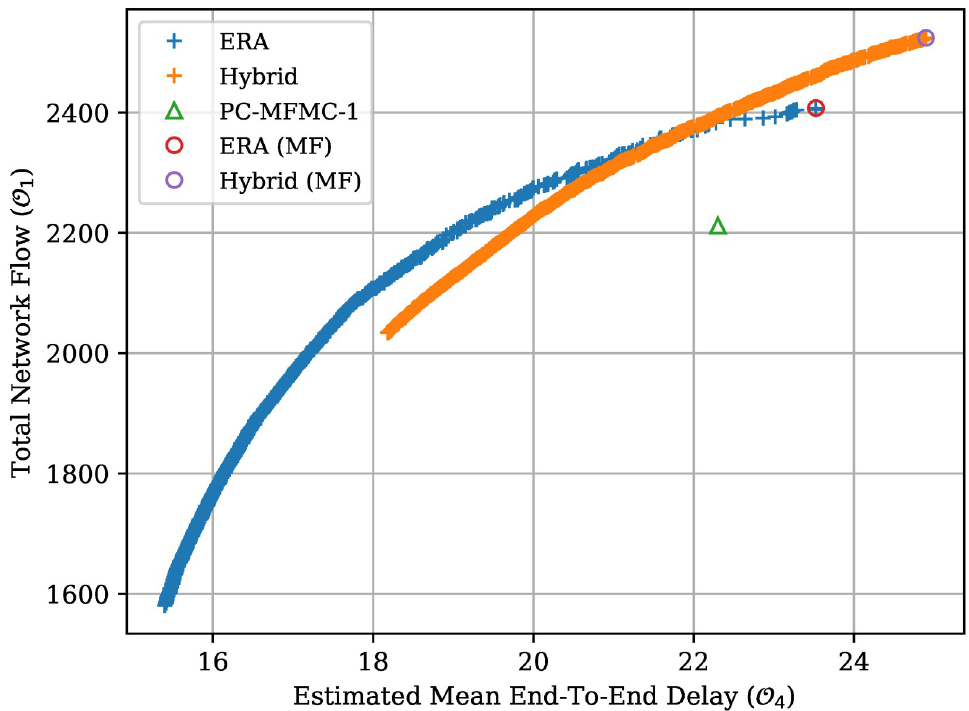
Fig 9. Hybrid vs Non-Hybrid Pareto Front. ERA represents the Pareto Front generated by ERA when the population is generated entirely at random. Hybrid represents the ERA and LP hybrid routing algorithm. PC-MFMC-1 represents the solution found by LP when only the shortest path is available and is used to represent the maximum attainable network flow by OSPF. MF marks the solution with the largest Network Flow value.